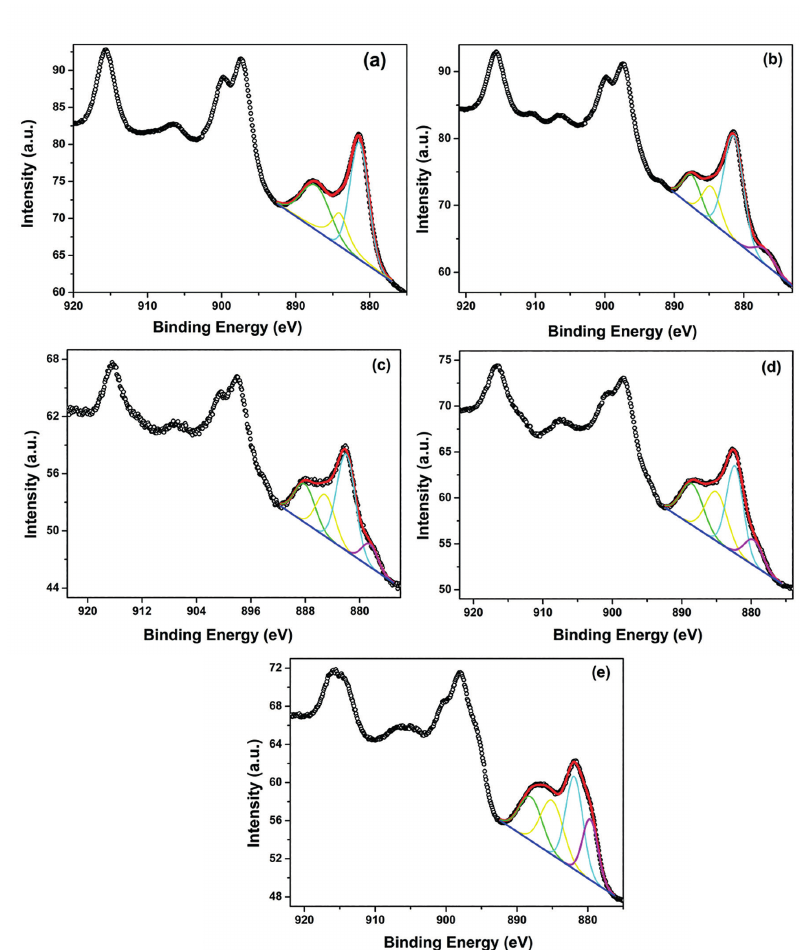
Figure 6: Ce 3d XPS-spectra for the following samples: (a) CGd, (b) CGd-0.2Zn, (c) CGd-0.4Zn, (d) CGd-1Zn, and (e) CGd-Co.